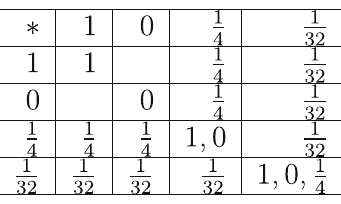
Fig. 1 Fusion rules M of the Griess